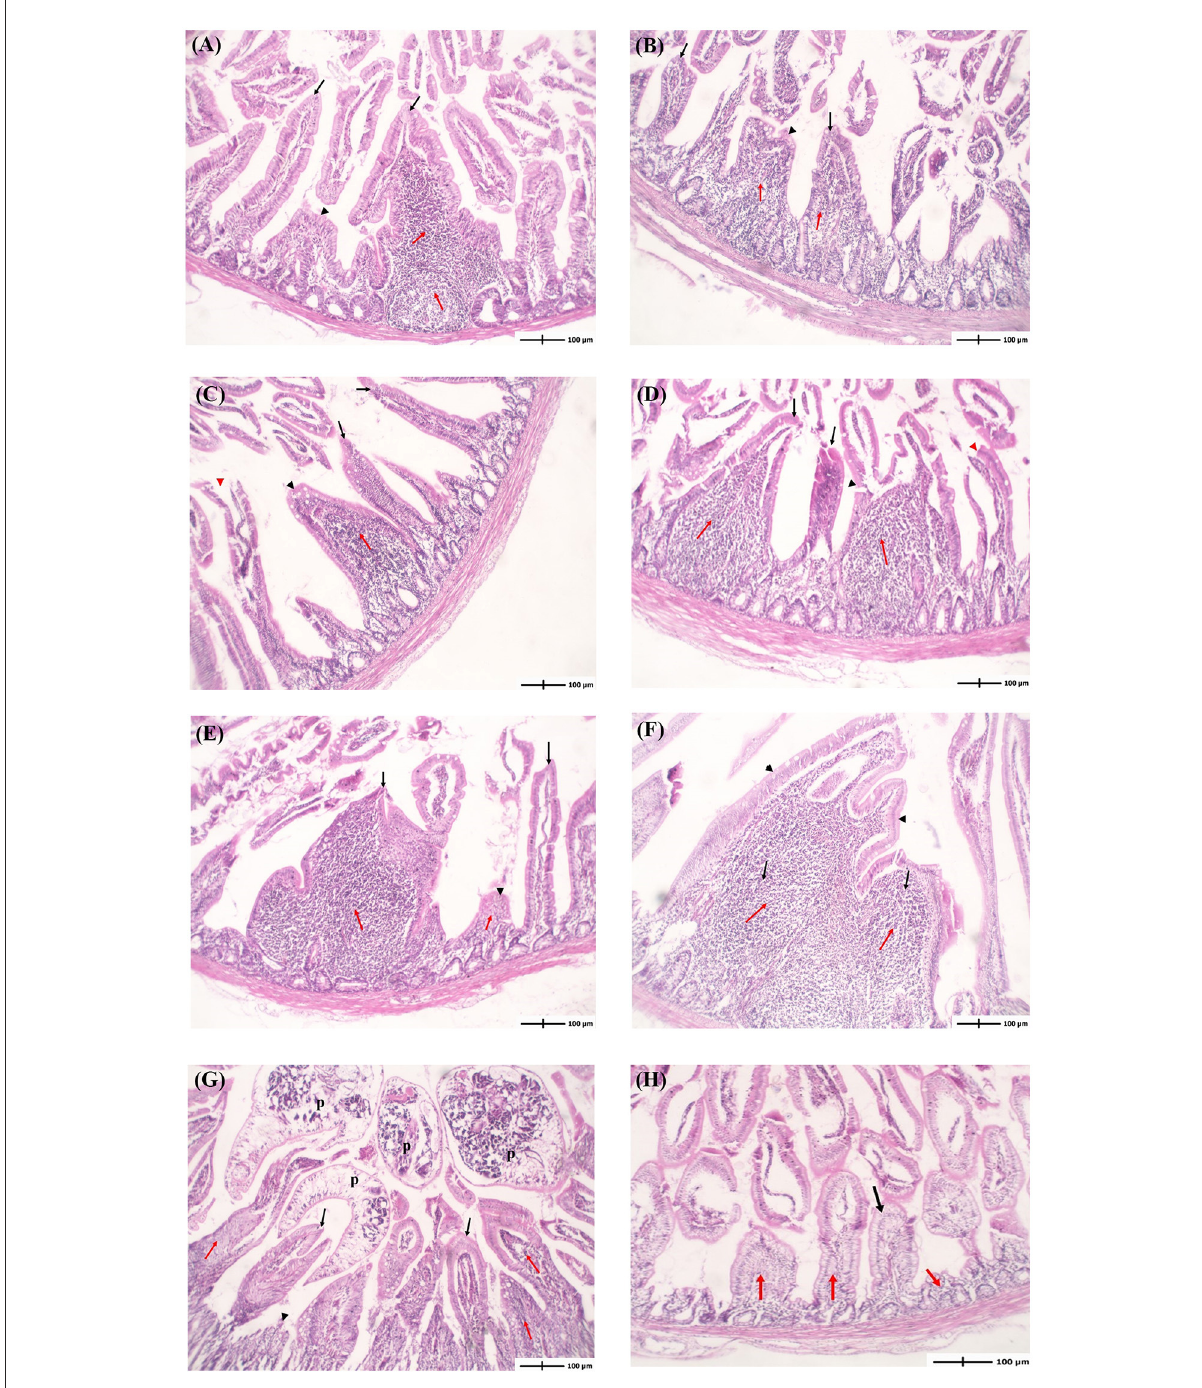
FIGURE4 Histopathological examination of the intestine of pigeons infected with Prohemistomum vivax . (A–F) Histopathological lesions in pigeons from 2-, 4-, 7-, 14-, 21-, and 28-dpi 1-6 groups, respectively. Intestinal tissues from groups 1-6 revealed variable extent of inflammatory cells infiltration in mucosal lamina propria (red arrows). Some villi are uniform (black arrows), others show shortening, thickening, or atrophy (black arrowheads), and others show focal surface ulceration (red arrowheads). (G) Adult flukes (p) entrapping intestinal villi. (H) Intestinal tissue from the negative control group revealed normal uniform intestinal villi (black arrows) with lamina propria showing few inflammatory cells (red arrowheads) and rounded uniform glands. In all figures, intestinal tissue sections were stained with H&E and at 100 ×